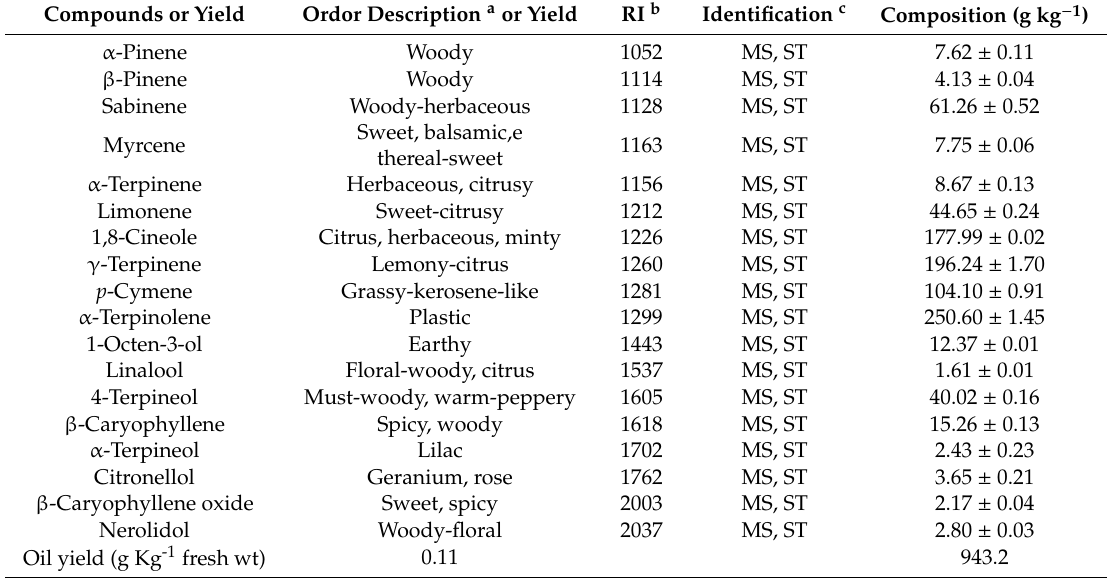
Table 1. Identification and composition of individual compounds in the